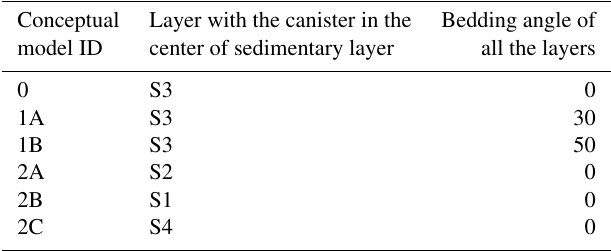
Table 2. Overview of the conceptual models including the location of the canister and the orientation of